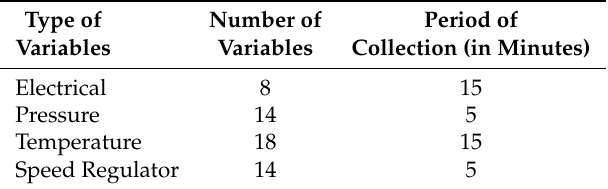
Table 2. Distribution of Variables in Categories and Collection Time Interval per